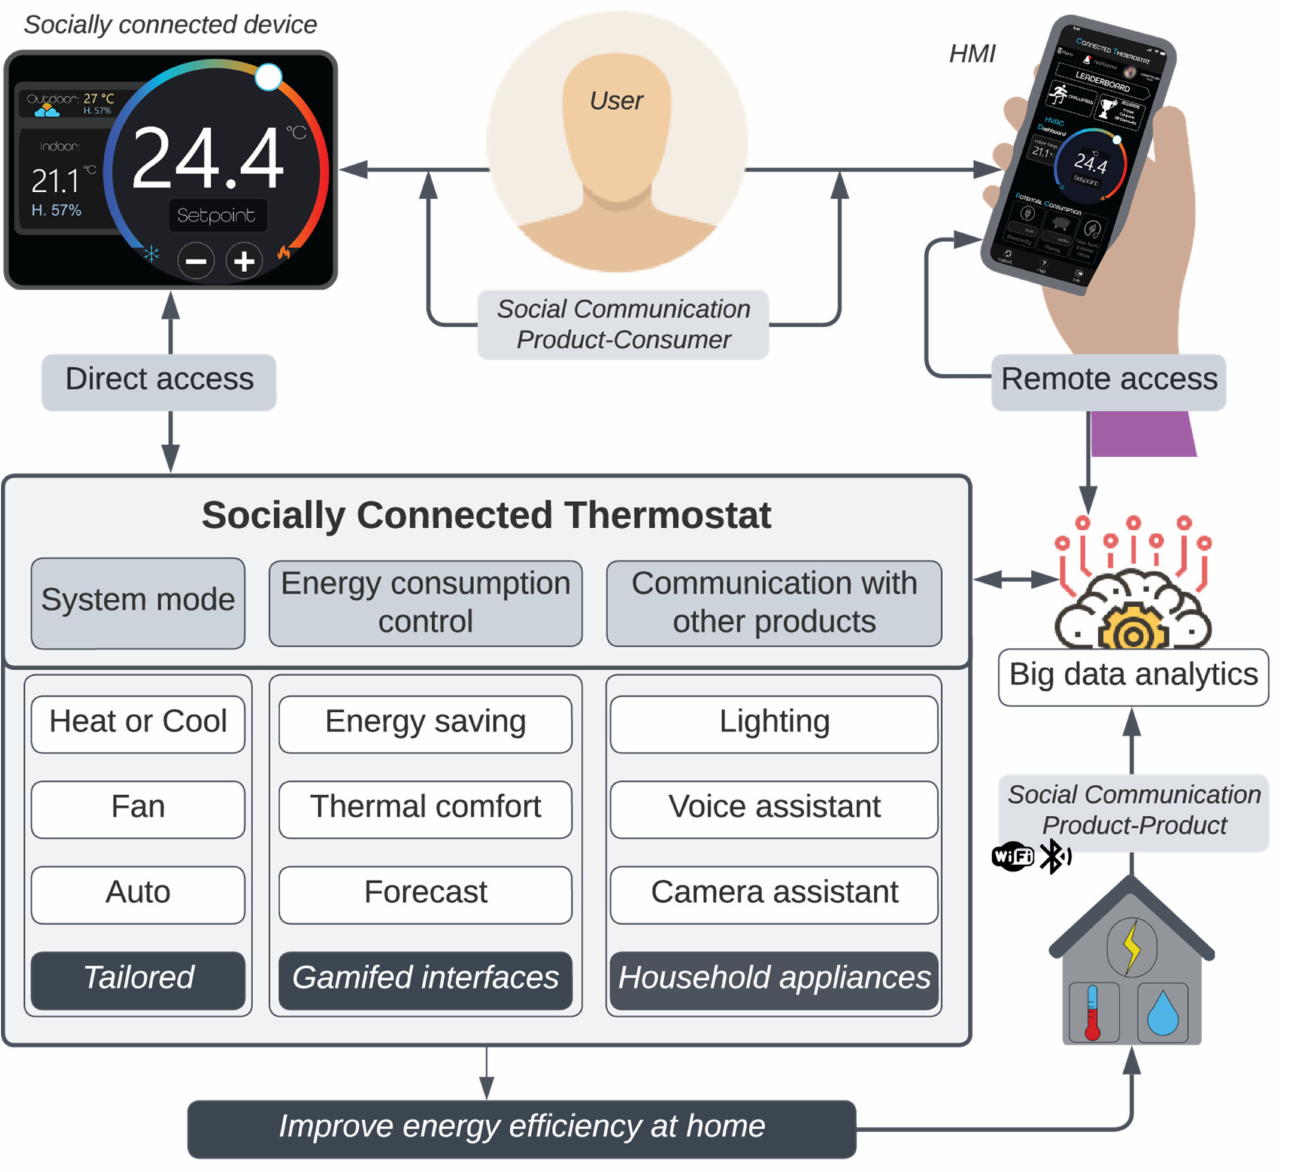
Figure 1. Socially connected products: Connected thermostats are used as an example of this